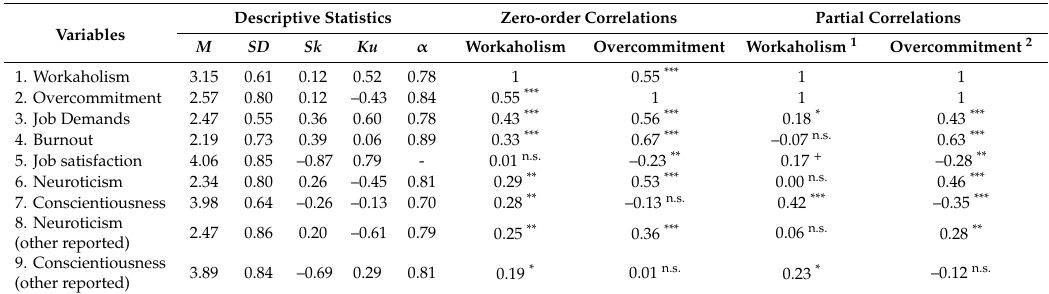
Table 1. Descriptive Statistics, Reliability, Zero-order Correlations, and Partial Correlations.